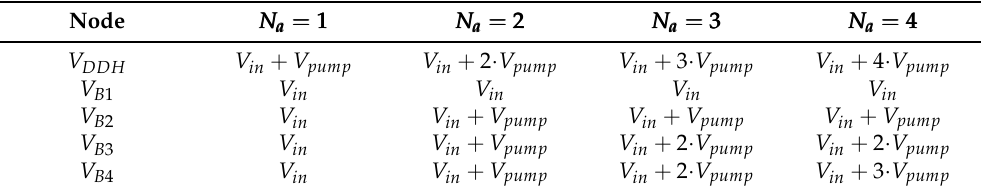
Table 1. DC-DC converter’s output voltage and biasing voltages, depending on the number of stages enabled. V pump is defined in